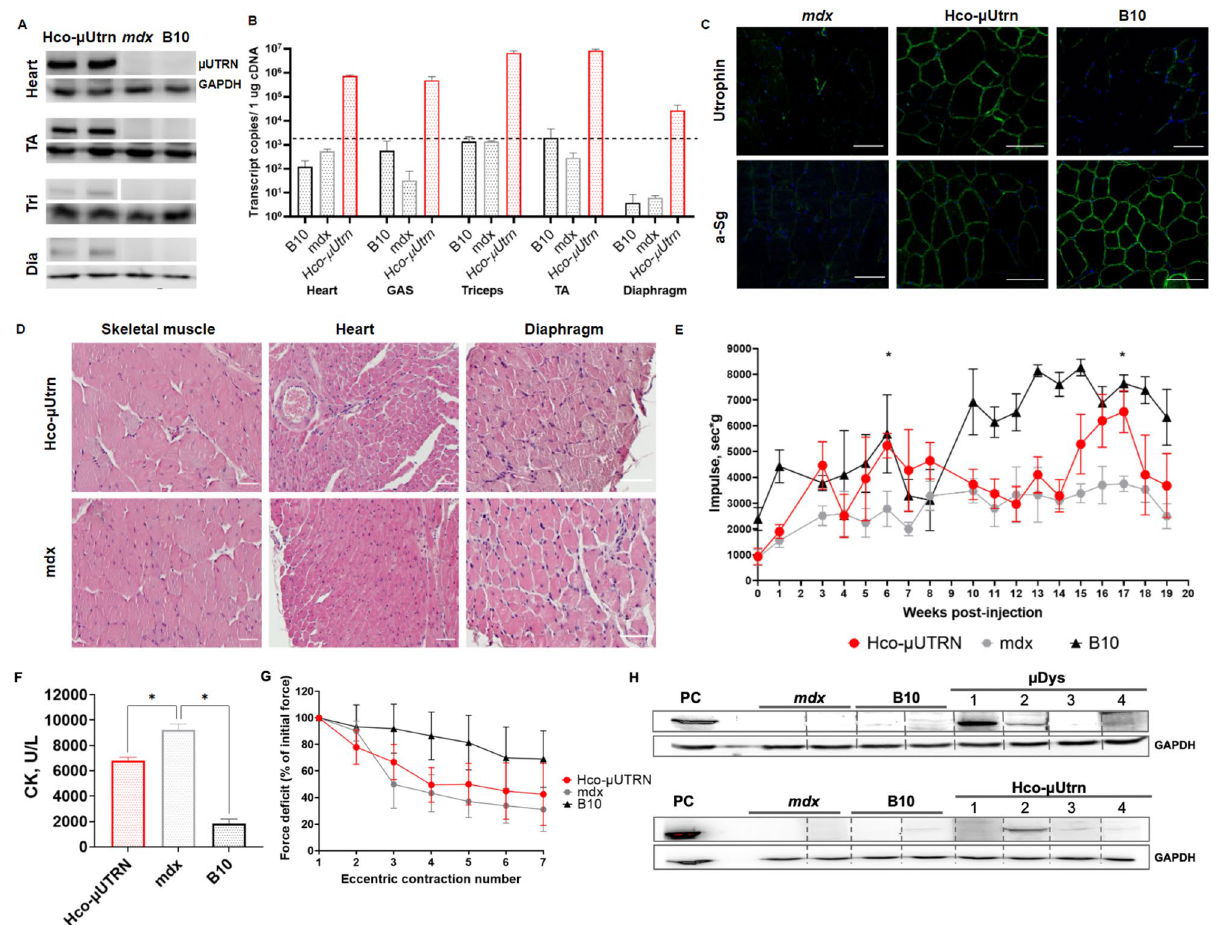
Figure 3. Systemic delivery of rAAV9-Hco-µUtrn at dose 6 × 10 14 vg kg −1 for twenty-week studies in mdx mice. ( A ) Western blot analysis of recombinant µUtrn expression in the heart, tibialis anterior (TA), triceps (Tri), and diaphragm (Dia); loading control, GAPDH. Unprocessed full-length blots are presented in Supplementary Figure S10. ( B ) RT-qPCR analysis of Hco-µUtrn expression in the heart, gastrocnemius (GAS), triceps, TA, and diaphragm. The dashed line represents the detection levels of negative controls. ( C ) Representative images of TA muscle cryosection immunofluorescence analysis after rAAV9-Hco-µUtrn administration. Native and recombinant utrophin as well as α-sarcoglycan were colored in green. Nuclei were counterstained with DAPI (blue). Scale bar, 100 µm. ( D ) Representative images of hematoxylin and eosin (H&E)-stained skeletal muscle, heart, and diaphragm (see Fig. S2 for more organs). Scale bar, 100 µm. ( E ) Hanging wire test. The maximum hanging time of three trials during a 300-s wire test protocol normalized to mouse mass. ( F ) Creatine kinase (CK) levels in serum. ( G ) Percentage force drop following 20% eccentric contraction of TA muscles of mdx mice administered rAAV9-Hco-µUtrn compared to those of vehicle control mice. ( H ) Western blot analysis of Hco- µUtrn- and µDys-specific antibodies in the sera of treated mice (1:100 dilution). PC—positive control, sample incubated with antibodies against utrophin (Cau22354) and dystrophin (DysB); loading control, GAPDH. Unprocessed full-length blots are presented in Supplementary Figure S10. All values are presented as the mean ± SEM (n = 4 mice), and statistical significance was set at P < Intramuscular injection of rAAV9‑Hco‑µUtrn‑FLAG virus led to expression on the sarcolemma of TA muscles and functional improvements in mdx mice. To distinguish between native utrophin and recombinant µUtrn during immunofluorescence, the FLAG epitope tag was used as a transgene marker. The addition of an N-terminal FLAG tag to the µUtrn sequence has been reported previously 20,21 . In the present study, the Hco-µUtrn protein C-terminus was modified with the DYKDDDDK peptide sequence, allowing for detection of the transgene using antibodies against the utrophin N-terminus and the FLAG epitope. To deter- mine whether the FLAG-tag had a negative impact on Hco-µUtrn expression, localization, and functionality, we injected rAAV9-Hco-µUtrn and rAAV9-Hco-µUtrn-FLAG into the TA muscles of mdx mice (2 × 10 12 vg per TA muscle). Two weeks post-injection, transcript levels and function were analyzed. Hco-µUtrn-FLAG as well as Hco-µUtrn were successfully expressed on the sarcolemma of TA muscle cells (Fig. 4A, UTRN). Antibodies against the FLAG epitope recognized the Hco-µUtrn-FLAG protein (Fig. 4A, FLAG). The expression level was similar for both transgenes (Fig. 4B). Further, both rAAV9-Hco-µUtrn- and rAAV9-Hco-µUtrn-FLAG-treated